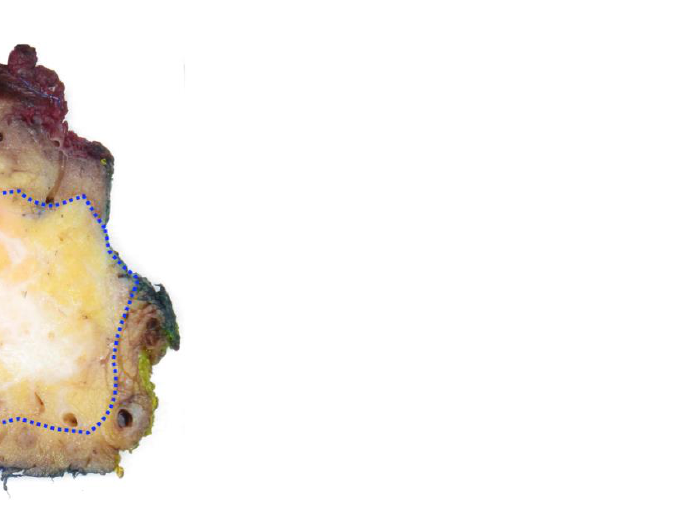
Figure 4. Microscopic corroboration of tumour size. This axial slice from a pancreatoduodenectomy specimen with a largely dilated common bile duct (metal stent removed) shows an ill-defined tumour. The true tumour border, as identified by microscopic examination of this tissue slice, is indicated on the macroscopic image (dotted line) and includes parts of pancreatic tissue that on naked-eye inspection appear clear of tumour. Consequently, the tumour size based on microscopic corroboration (2D-micro) exceeds the one assessed by naked-eye inspection (2D-macro).